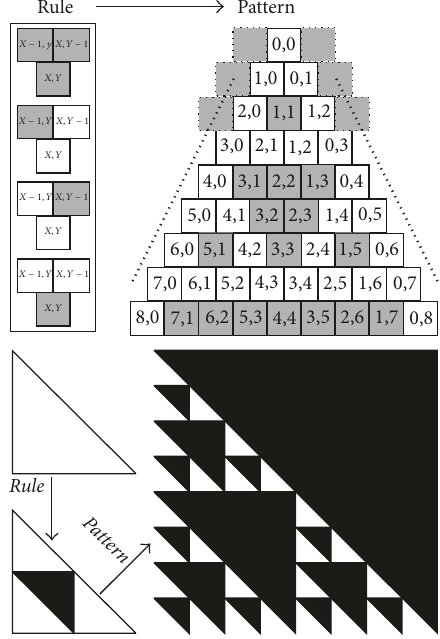
Figure 3: Template generation from 2 different kinds of rules, signifying its relation to the Sierpinski triangle/fractals and the cellular